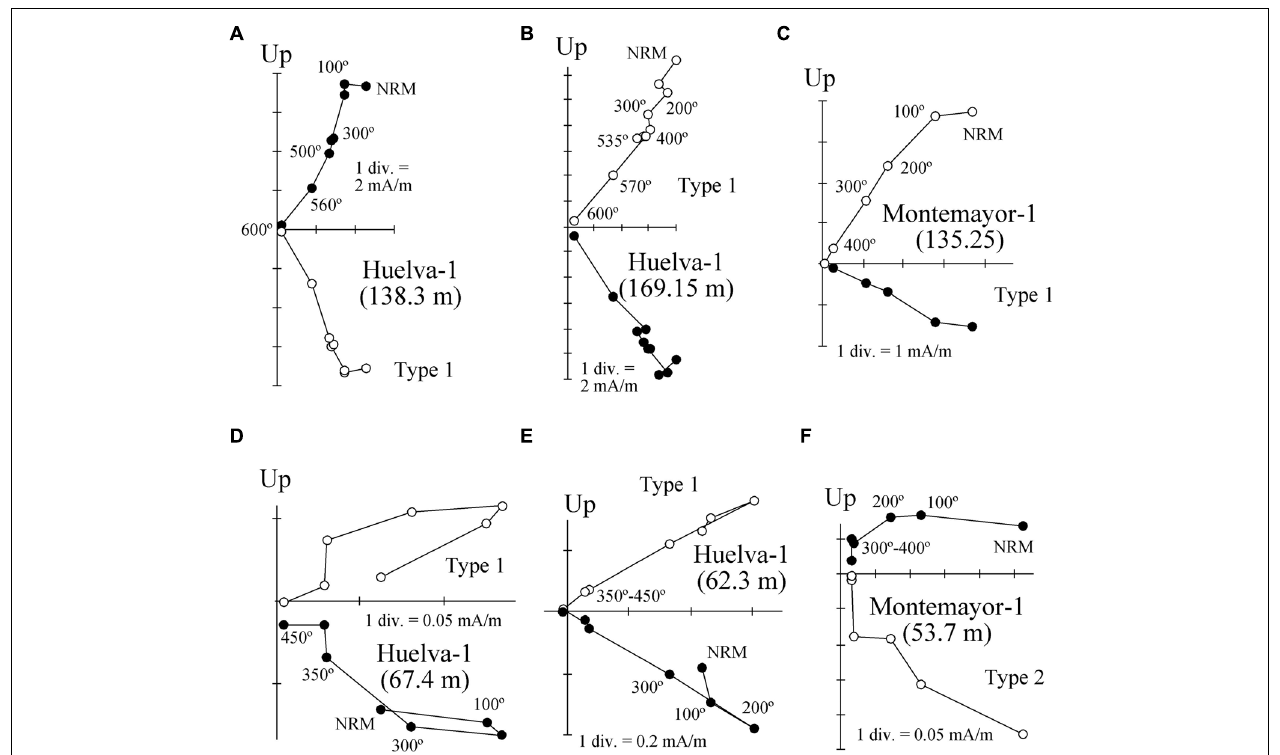
FIGURE 5 | Representative orthogonal demagnetization diagrams for samples from the Huelva-1 and Montemayor-1 boreholes. Samples are azimuthally unoriented, so declinations are meaningless.The stratigraphic positions for each sample are indicated in parentheses. (A–C) Samples with high NRM intensities. (D–F) Samples with weak